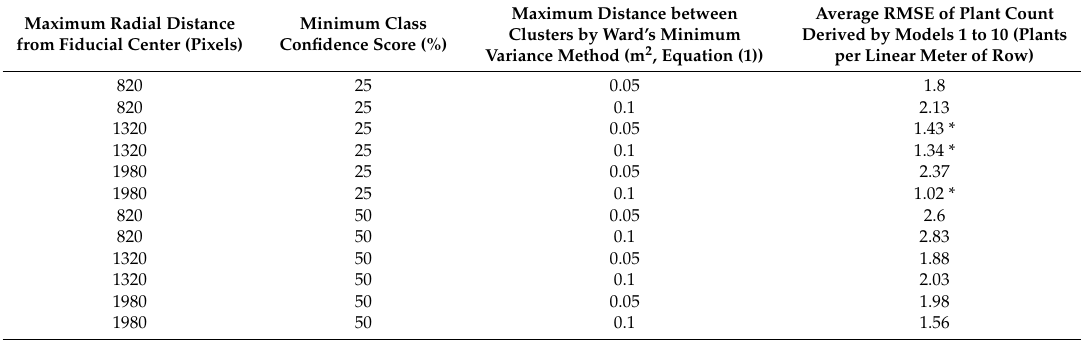
Table 4. Average root mean square error (RMSE) of unmanned aircraft systems (UAS)-based plant count of Models 1 to 10 depending on di ff erent combination of screening and clustering parameters. Maximum Distance between Average RMSE of Plant Count Maximum Radial Distance Minimum Class Clusters by Ward’s Minimum Derived by Models 1 to 10 (Plants from Fiducial Center (Pixels) Confidence Score (%) per Linear Meter of Row) Variance Method (m 2 , Equation (1))